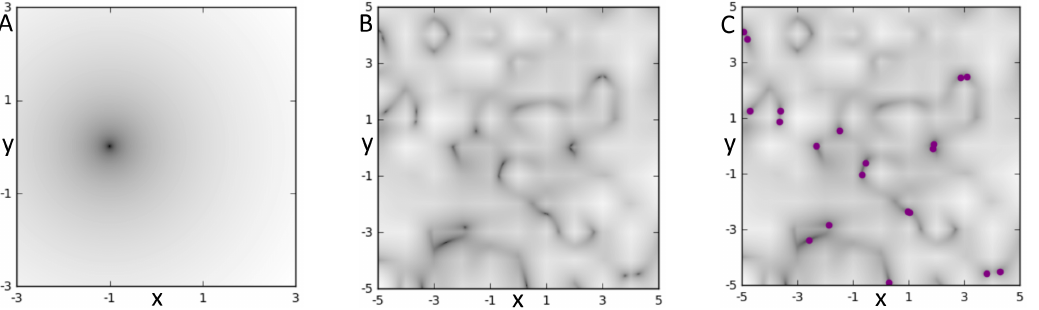
Figure 7: Curvature in the pure isotropic model. A: Heat map of the time-dilation factor γ [ Eq. (25) ] for the “disorder space” isotropic manifold, with v = y in Eqs. (37a) and (37b). We note that there is a single isolated curvature v N singularity. B: A heat map of the time-dilation factor for a random realization of pure isotropic quenched gravity. C: The heat map in B annotated to mark the locations of isotropic